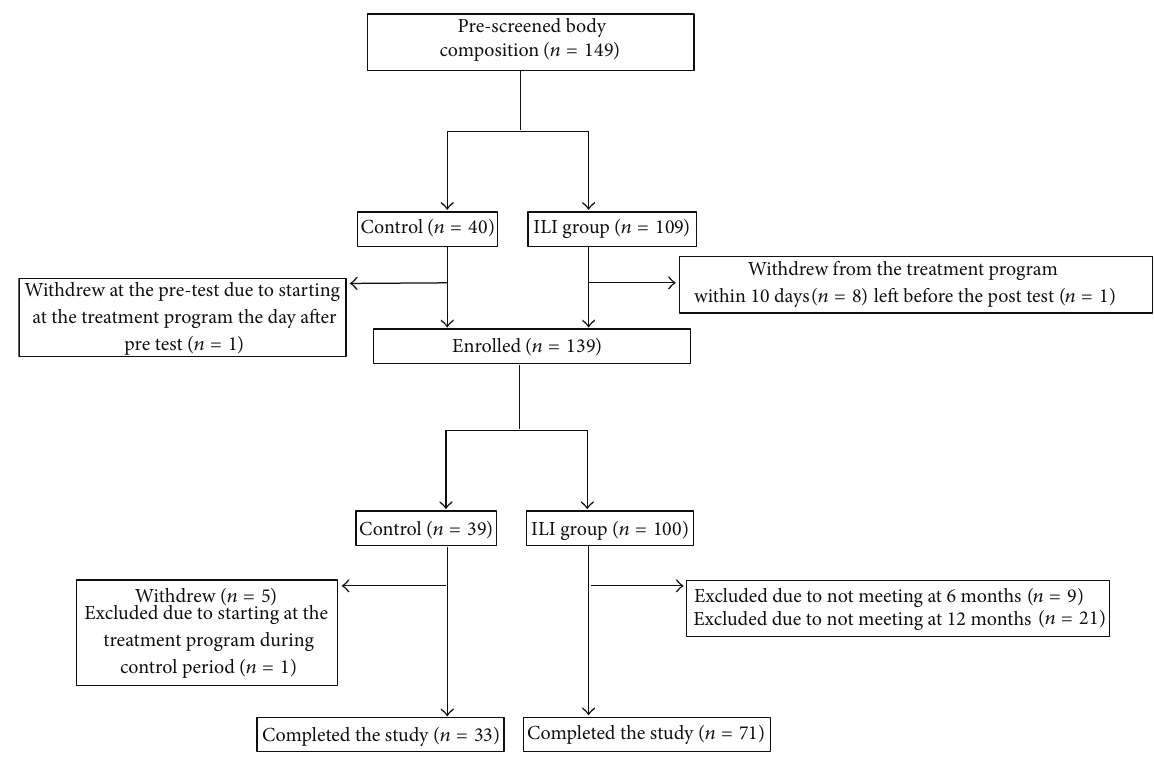
Figure 2: Flow of participants throughout the